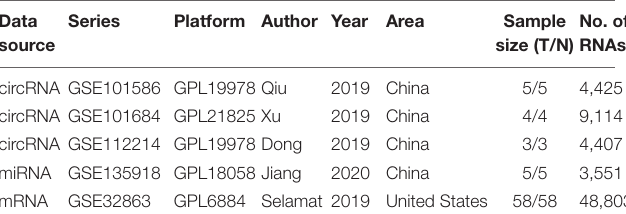
TABLE 1 | Basic information of five microarray datasets from the GEO database.